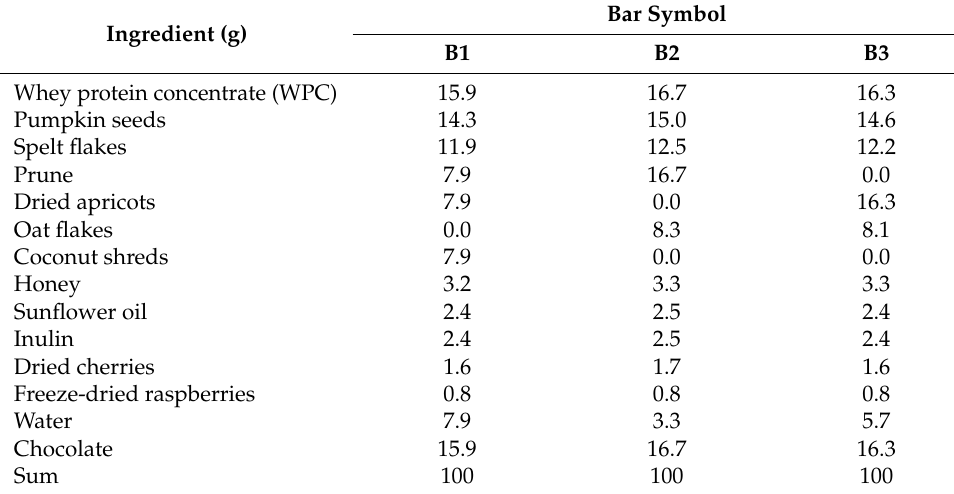
Table 1. Variants of study beer beverages and their